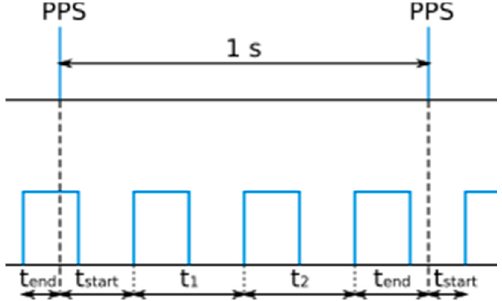
Figure 7. Schmitt -trigger output signal chopped by the 1 PPS pulses. This allows for measuring the signal phase and the Allan Variance.